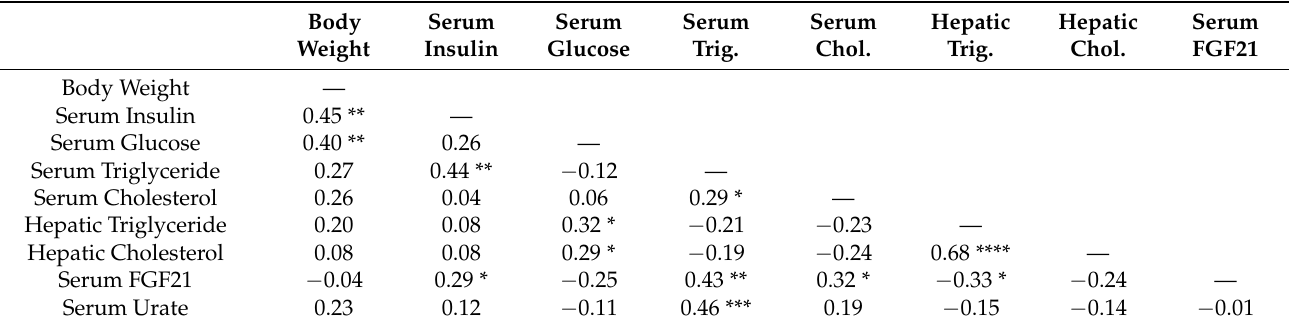
Table 2. Pearson intercorrelations (R) between metabolic traits within male F2 cohort. Body Weight